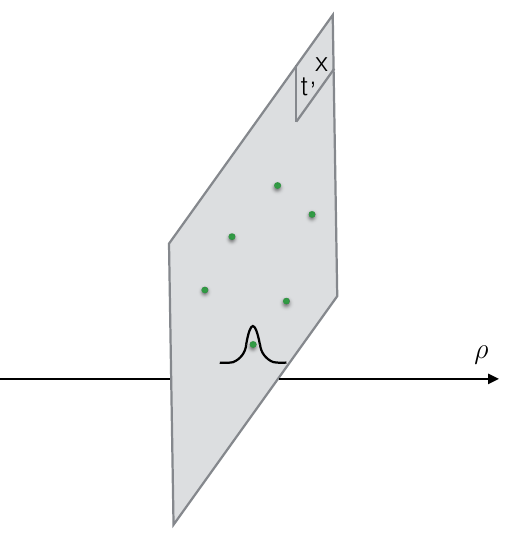
Figure 3 . Schematic plot of the solitons and the overlapping